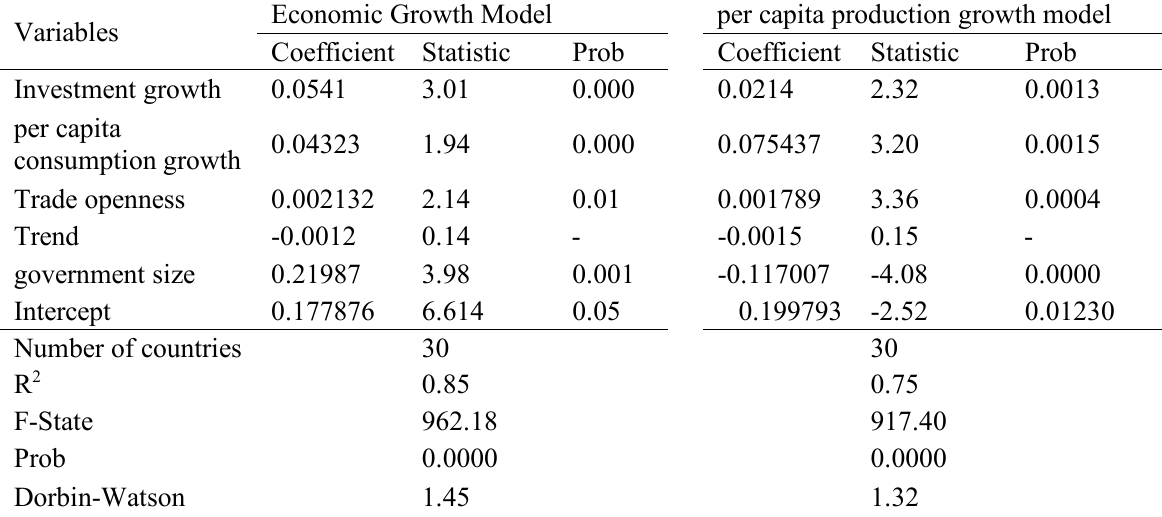
Table 3 . Results of Estimation of Two Patterns of Economic Growth and production growth per capita in Developed Countries